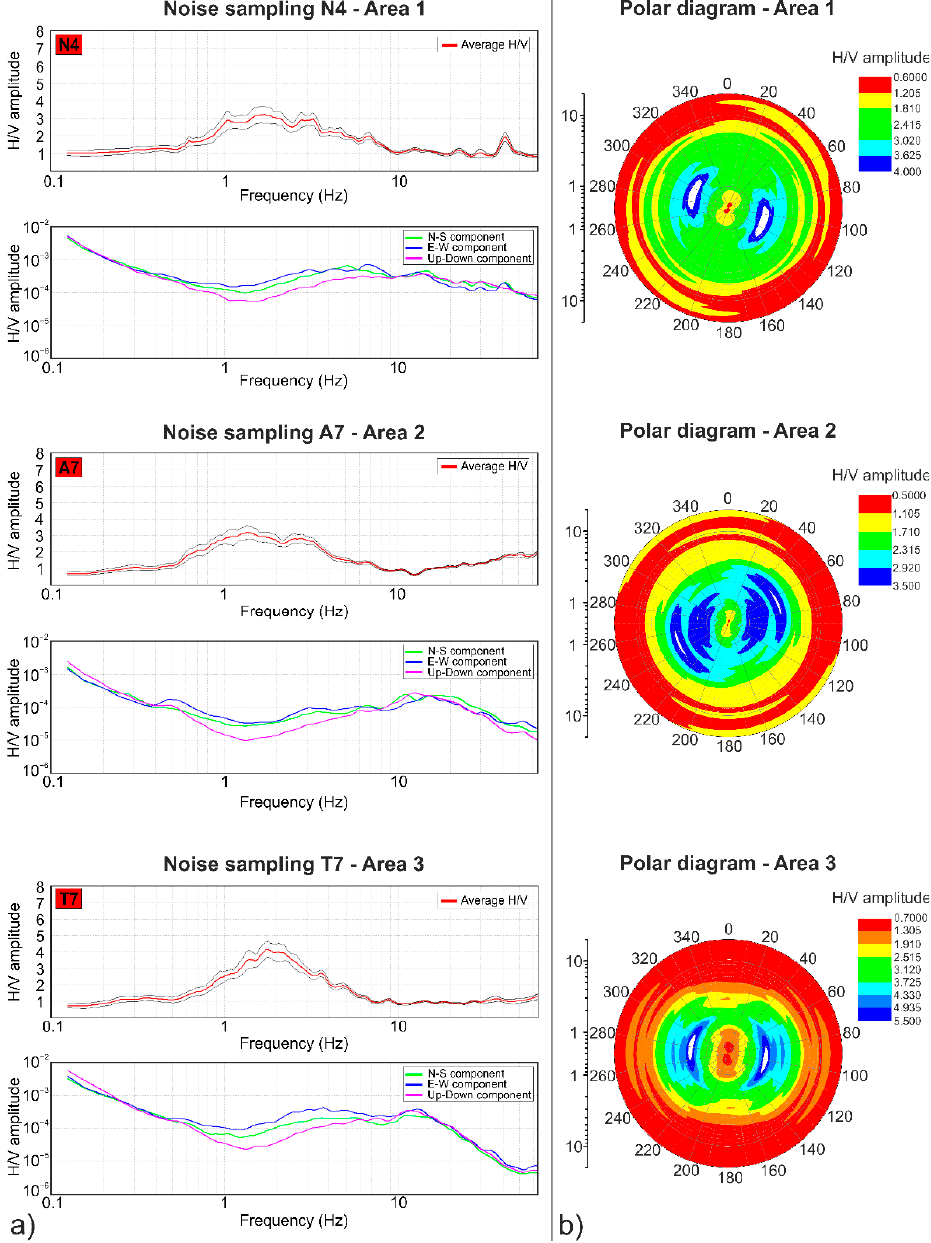
Figure 4. ( a ) Examples of HVSR spectra ( up ) and spectral amplitudes of single components ( down ) and polar diagrams ( b ) relating to seismic ambient noise records.